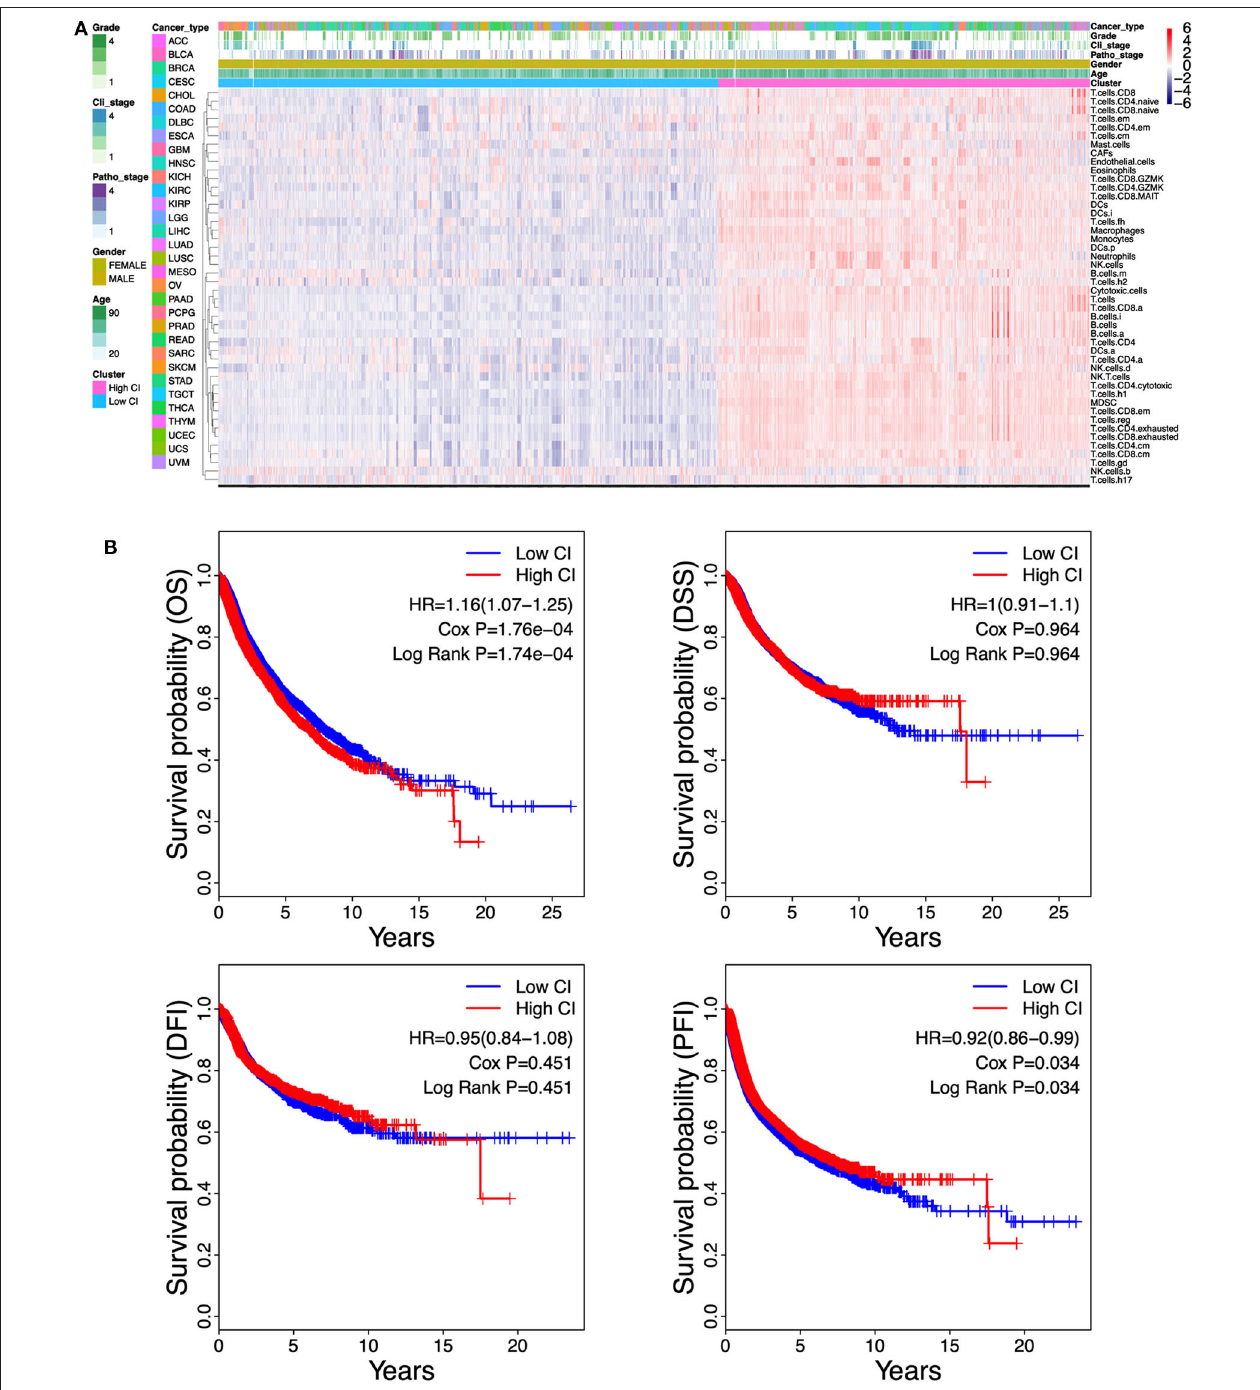
FIGURE 2 | Correlation between the immune cell infiltration and survival in the pan-cancer cohort. (A) Unsupervised clustering separates The Cancer Genome Atlas (TCGA) pan-cancer cohort of 9,112 patients into two distinct immunophenotypes using the single-sample Gene Set Enrichment Analysis (ssGSEA) scores which represent the 46-cell infiltration. “Red color cluster” represents “hot” tumors with more immune cell infiltration, “blue color cluster” represents “cold” tumors with less immune cell infiltration. (B) Kaplan–Meier curves estimate the survival differences between the high cell infiltration cluster and the low cell infiltration cluster. Survival differences between the two clusters were detected by both Cox regression and log-rank methods. OS, overall survival; DSS, disease-specific survival; PFI, progression-free interval; DFI, disease-free interval.